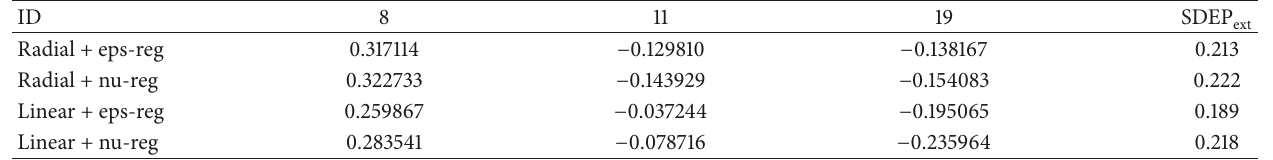
Table 8: Experimental and predicted values of lgt 1/2 residual and SDEP ext